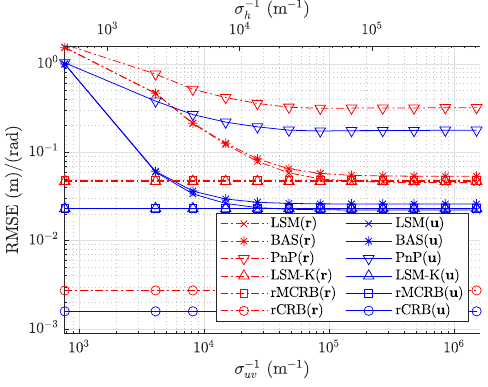
Figure 9. RMSE for position and orientation estimates as a function of σ uv and σ h